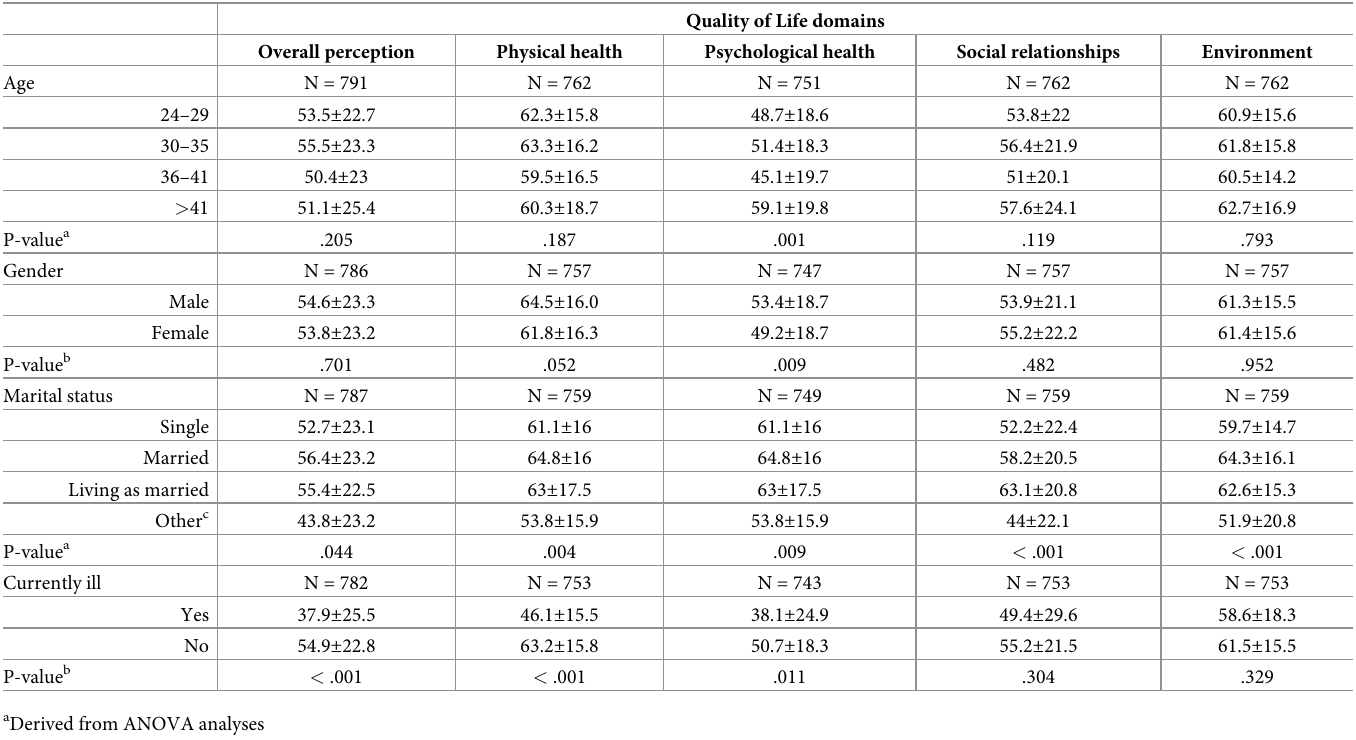
Table 3. Univariate analyses to assess the association between demographic variables and QOL measurements. Mean ± SD of standardized QOL scores are